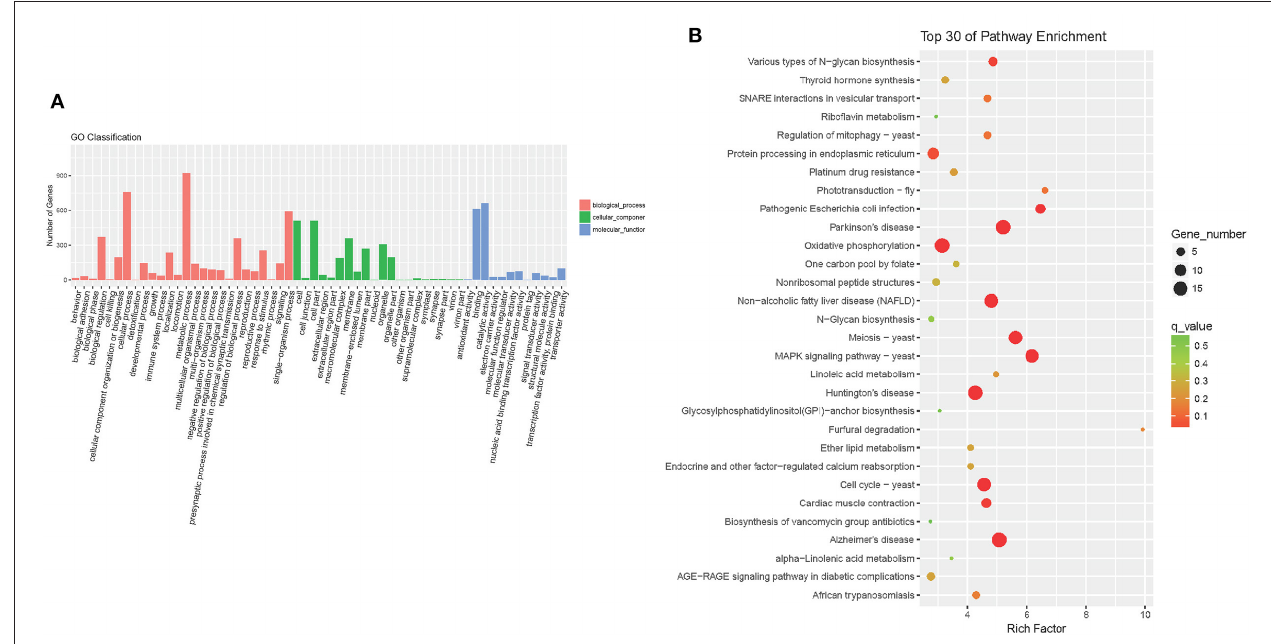
FIGURE 7 | Detection of GO enrichment (A) and the top 30 signaling pathways identified by KEGG using DAVID analysis (B)